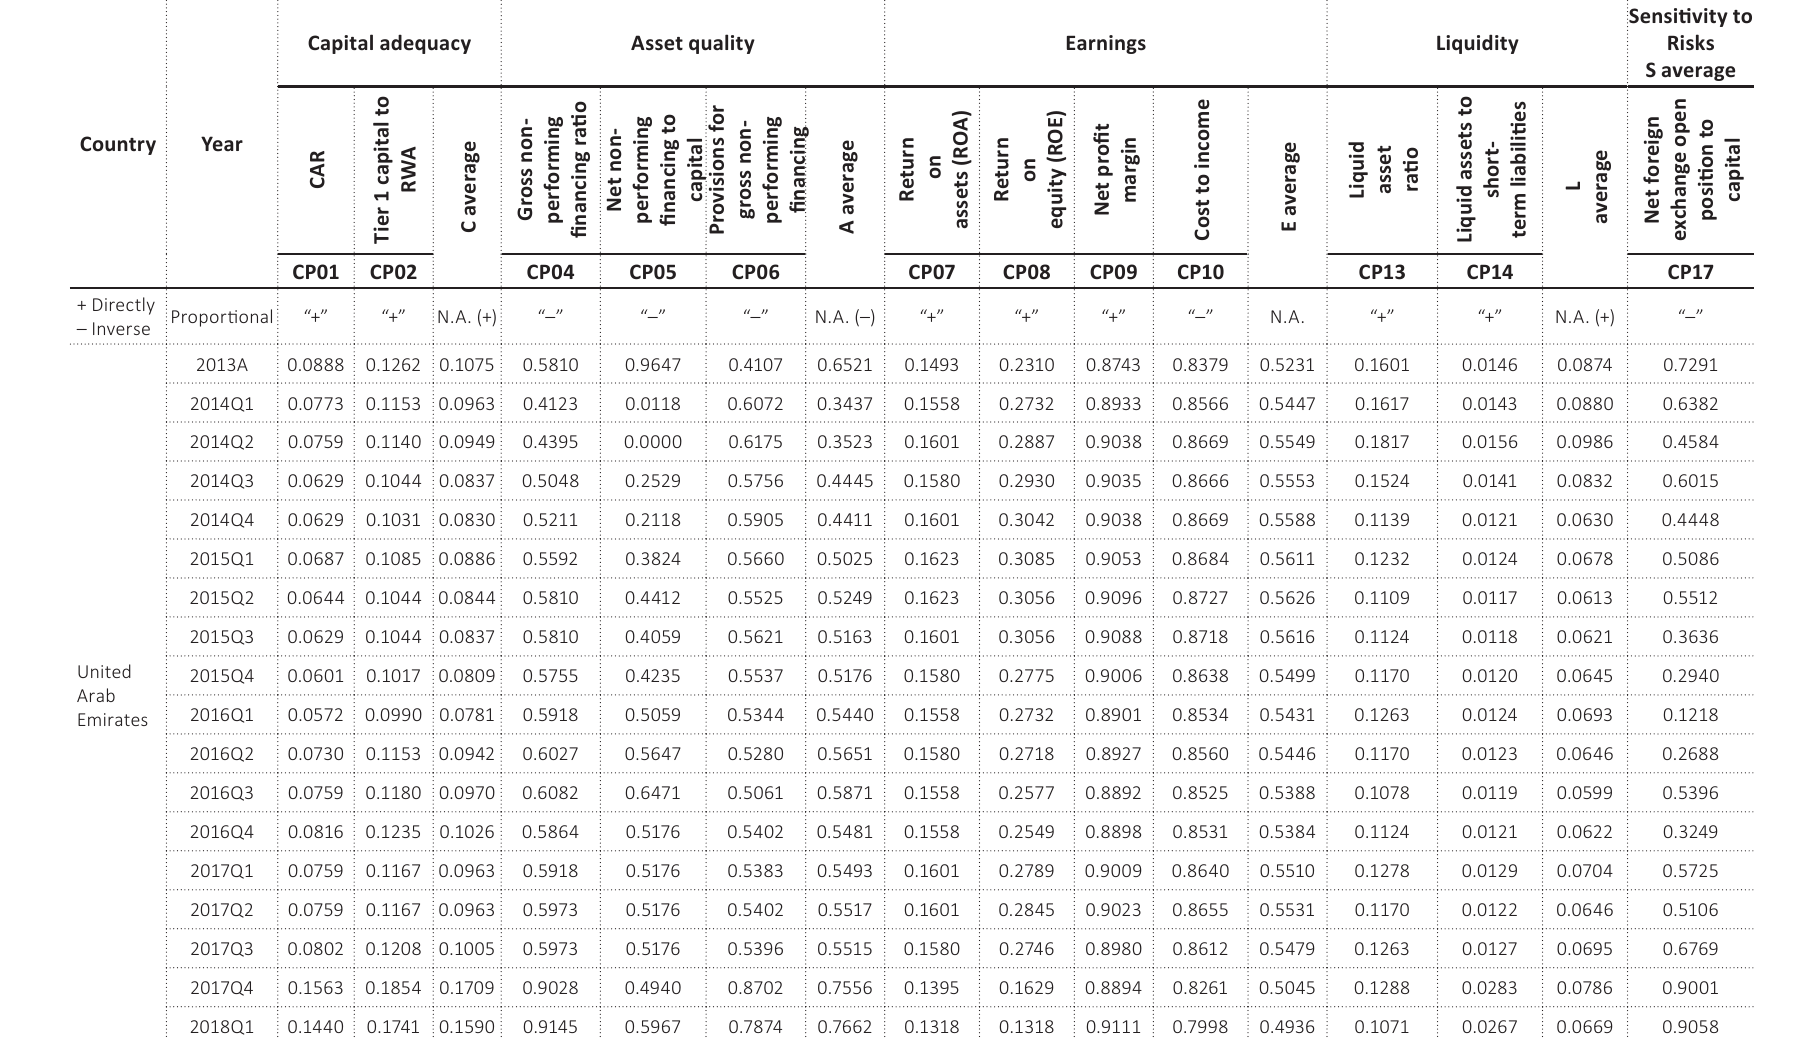
Source: Own calculation based on IFSB database Sensitivity to